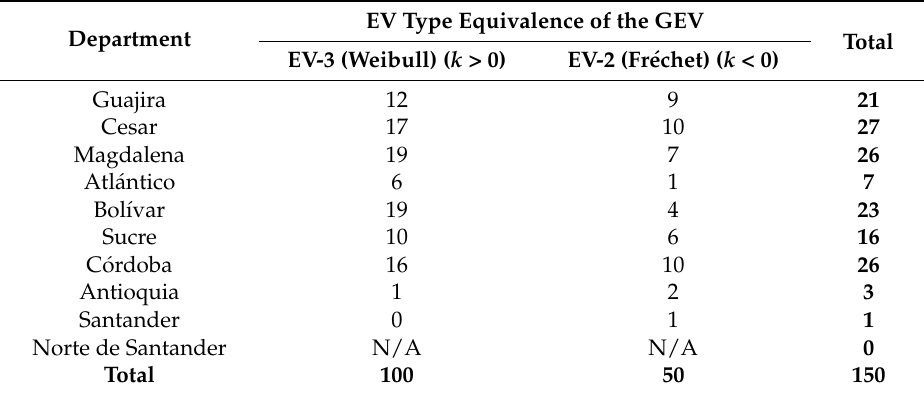
Table 5. EV distribution equivalence.